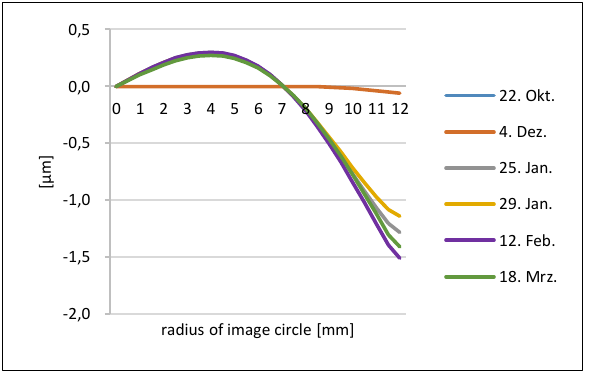
Figure 6: Deviation of radial-symmetric distortion (period of 5 month)